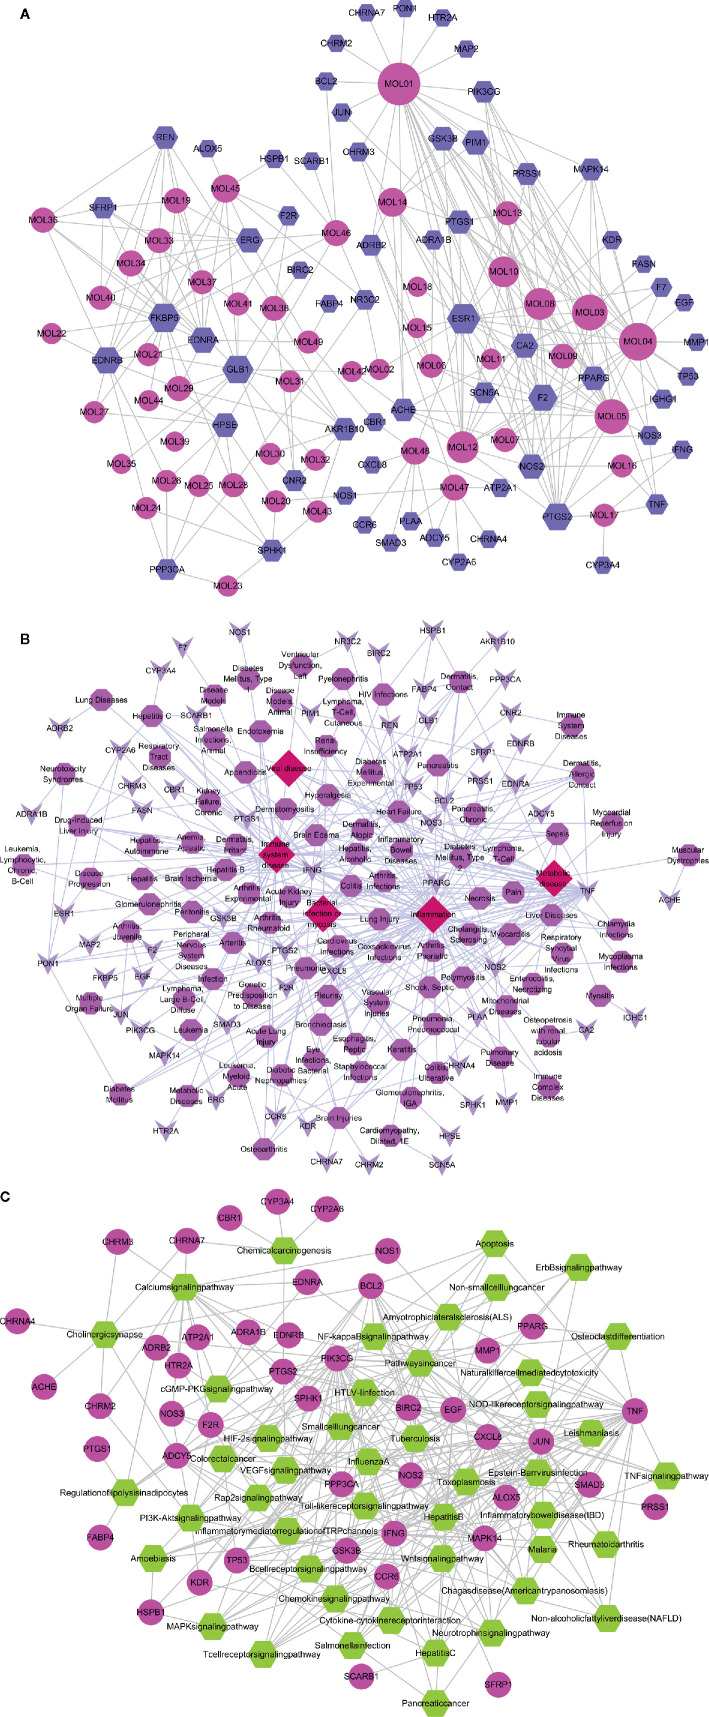
Compound-target-disease-pathway networks. (A) Compound-target network of SFH consisting of 113 nodes and 291 interactions. (B) Target-disease network including 46 candidate targets and 5 important diseases. (C) Target-pathway network including 45 candidate targets and 46 KEGG pathways.